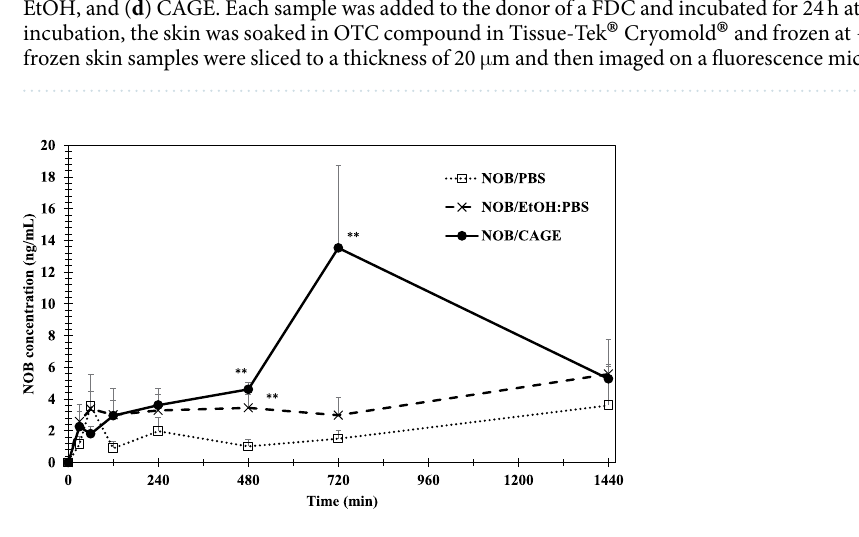
Figure 7. NOB concentration in the plasma after NOB/PBS, NOB/EtOH:PBS, and NOB/CAGE were transdermally administered. Using an electric shaver, the back hair of male SD rats was clipped in a circular shape and a FDC donor was fixed there using instant glue. A 2 mg/mL concentration of NOB/PBS, NOB/EtOH: PBS, or NOB/CAGE was percutaneously administered to the donor area of the rats (5 mg/kg). Each point represents the mean ± S.D. ( n = 5). The inter-group comparison was carried out using the non-repeated measures ANOVA followed by the Bonferroni test. ** Indicates a significant difference ( ** P < 0.01) compared with